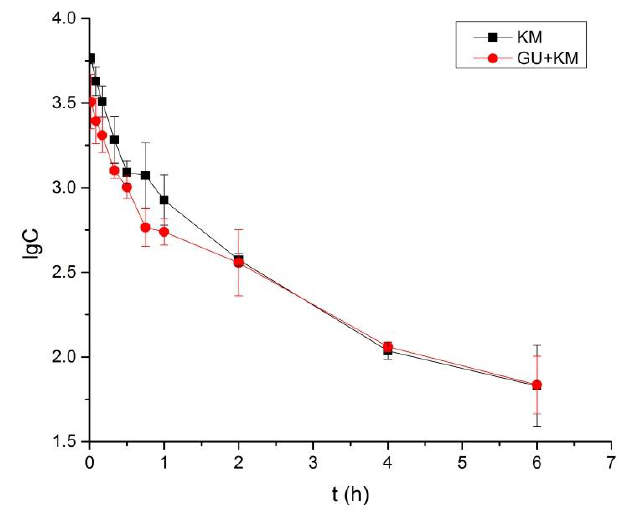
Figure 3. Mean ± SD (n = 6) plasma concentration-time profiles of koumine following intravenous administration of 10 mg/kg KM that received or did not receive Glycyrrhiza uralensis Fisch (GU) (3 g/Kg, once daily for 14 days).